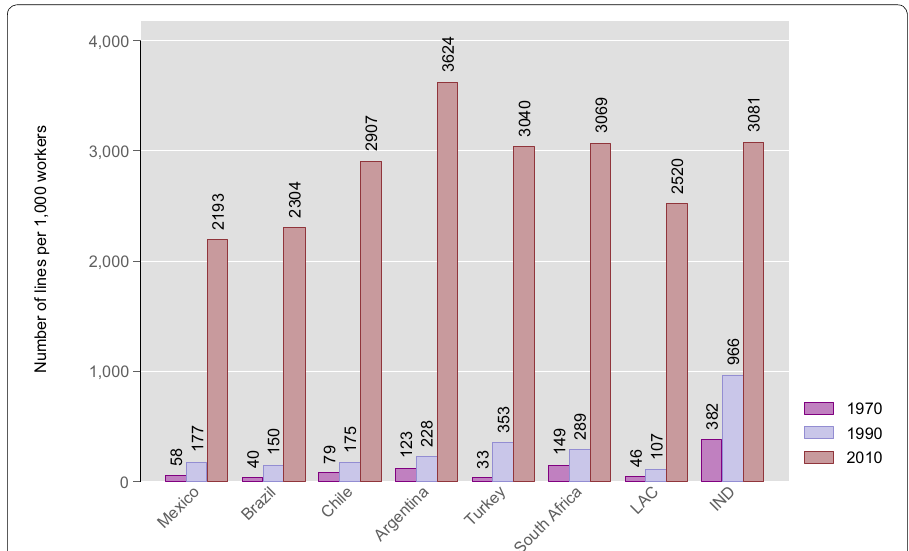
Fig. 1 Overview of telecommunications infrastructure. Note LAC region (excludes Mexico, Brazil, Argentina and Chile) and IND report medians Source: WDI and author’s